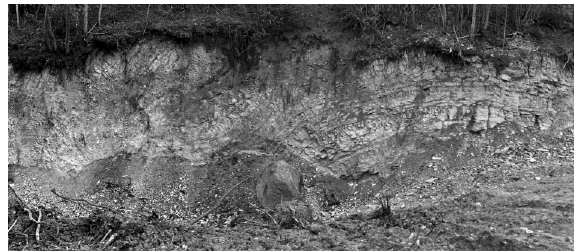
Fig. 9. Glacially folded and densely fissured carbonate rocks on the western side of Tornim(cid:228)gi Hill. Photo by A. Miidel.